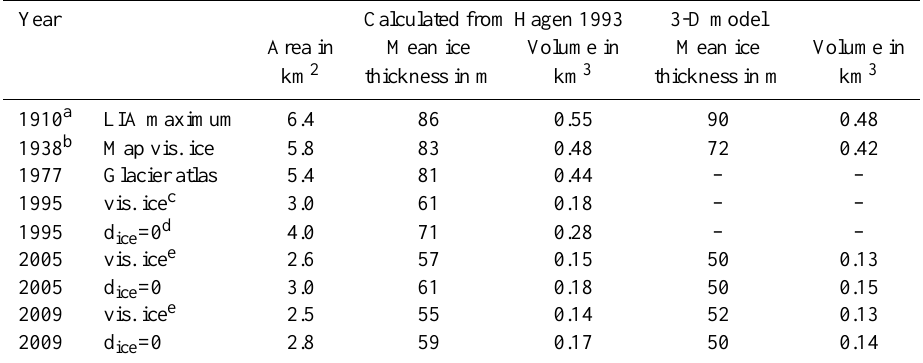
Table 1. Volume and areas from 3-D models and calculated by Eq. (1). The values are plotted in Fig. 4. Year Calculated from Hagen 1993 3-D model Area in Mean ice Volume in Mean ice Volume in km 2 thickness in m km 3 thickness in m km 3 1910